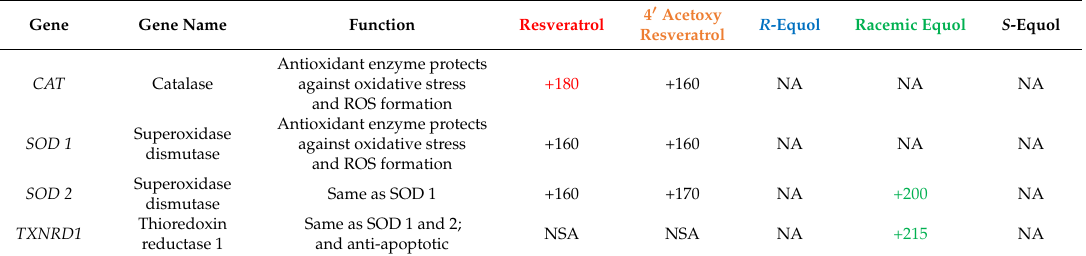
Table 6. Human skin antioxidant gene expression among resveratrol, 4 (cid:48) acetoxy resveratrol, R -equol, racemic equol or S -equol as the percentage of the increase (+) compared to controls.